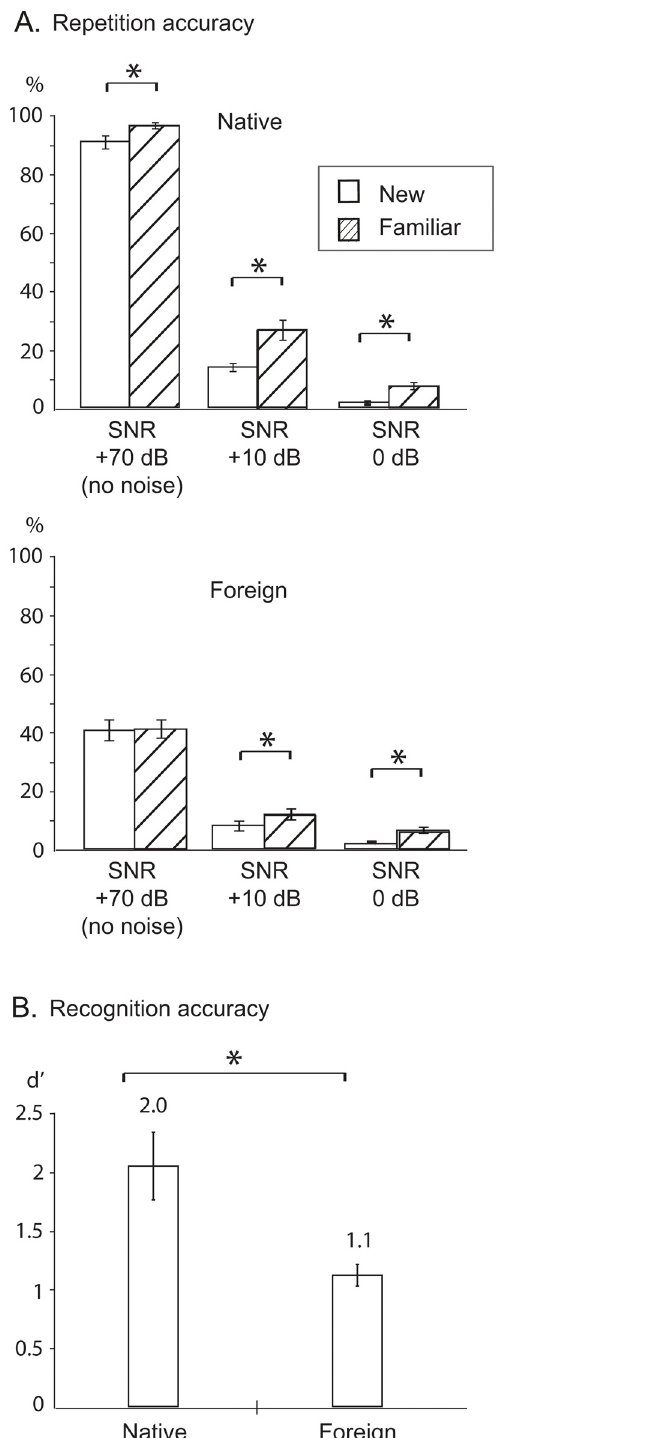
Fig 2. Behavioral effects. (A) Proportion of correctly repeated familiar and new foreign and native word forms (mean ± standard error of mean) in different levels of noise (signal-to-noise ratio = SNR +70 dB / +10 dB / 0 dB). * refers to p < 0.05. (B) Proportion of correctly recognized familiar foreign and native word forms (hits; mean ± standard error of